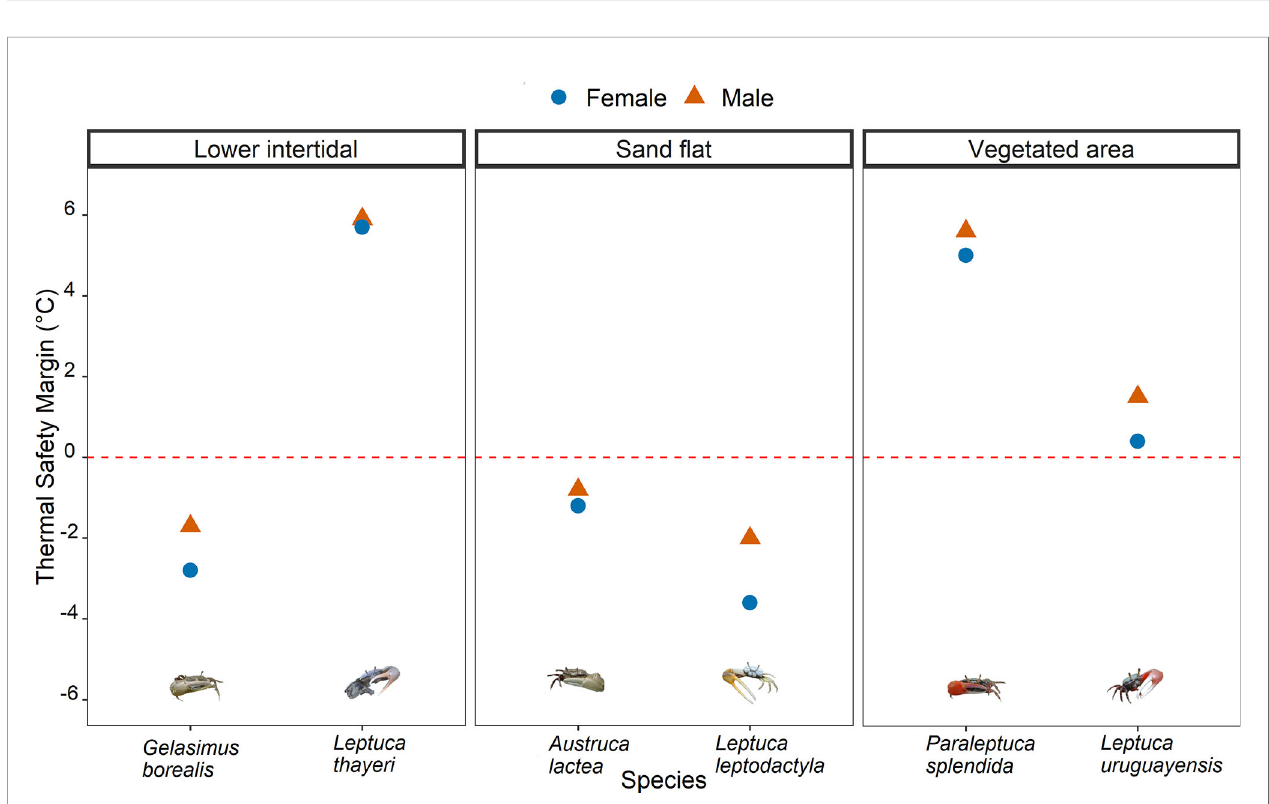
FIGURE 6 | Thermal safety margins of each species across habitats in the present study. Females are represented by blue circles and males are represented by orange triangles. Species on the left of each facet represent the Indo-West Paci fi c, species on the right of each facet represent the Atlantic East Paci fi